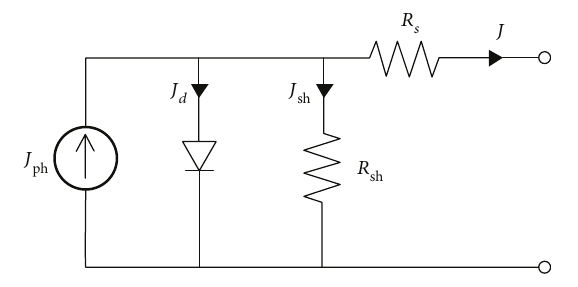
Figure 2: The equivalent circuit for a photovoltaic cell [38]. Table 1: Materials under test as the hole extraction layer [25]. Material